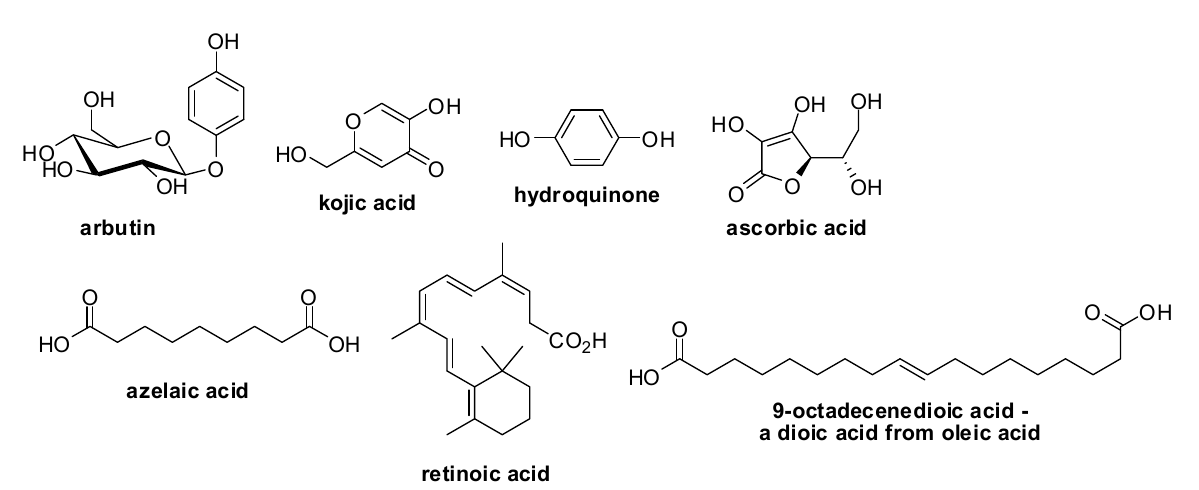
Figure 1. Structures of commercially used depigmenting